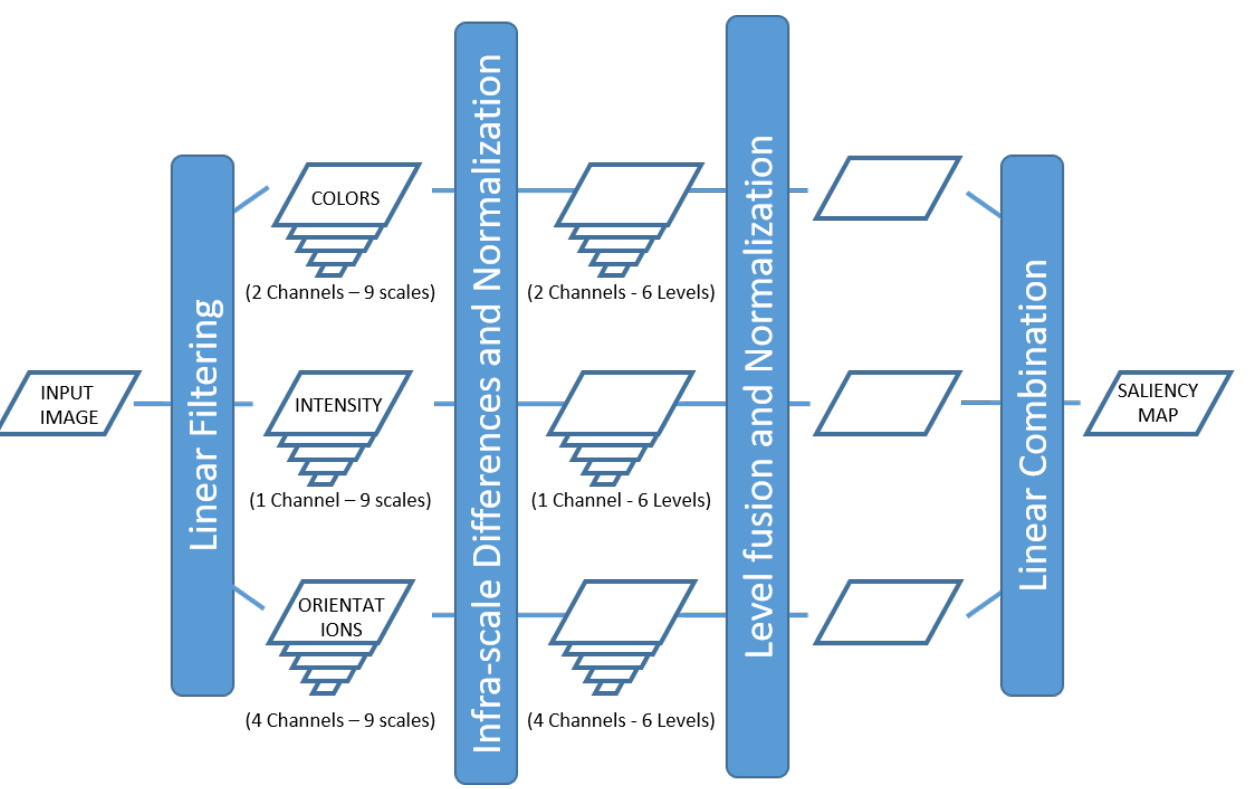
Figure 2. Itti, Koch, and Niebur Architecture.